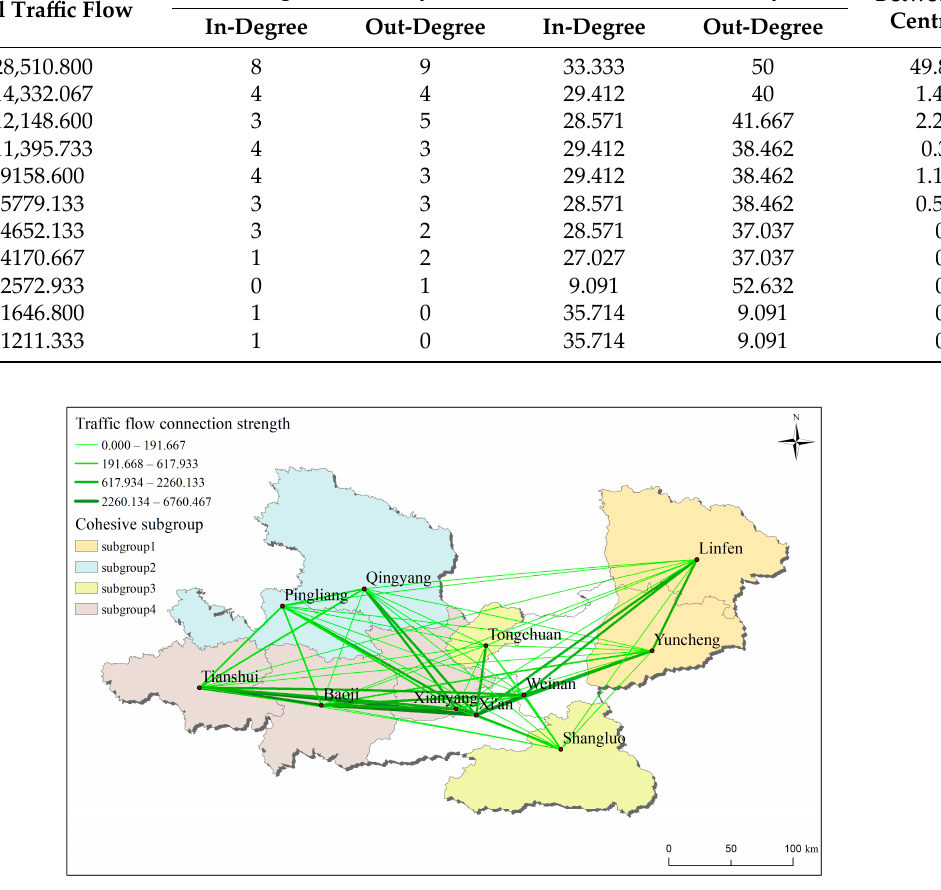
Figure 3. Spatial connection pattern of traffic flow and analysis results of cohesive subgroups. There are four cohesive subgroups of traffic flow. Subgroup 1 is Yuncheng and